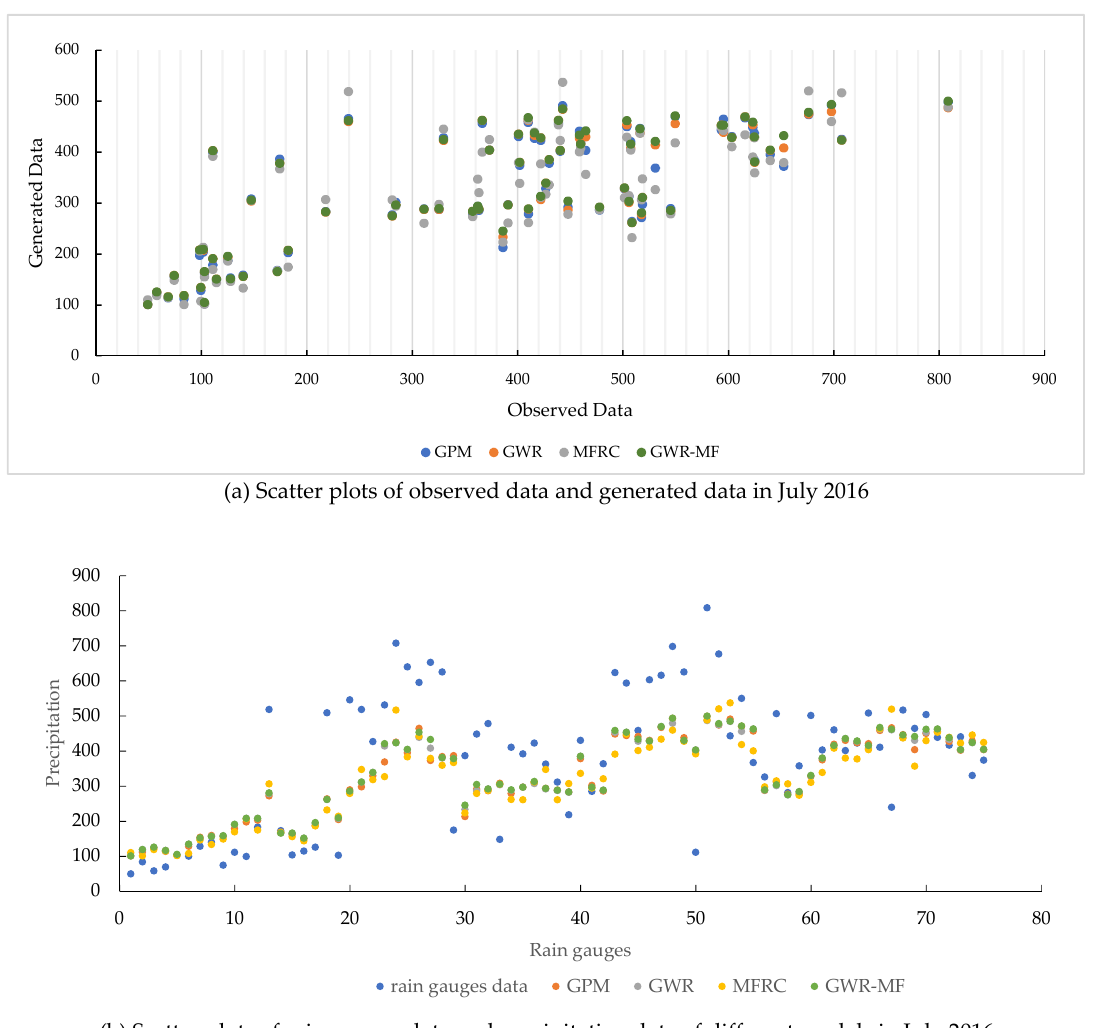
Figure 13. Scatter plots of rain gauges observation data and precipitation data of GPM product, GWR model, MFRC model, and GWR-MF model in July 2016. ( a ) Scatter plots of observed data and generated data in July 2016, ( b ) Scatter plots of rain gauges data and precipitation data of different models in July 2016. Table 2. CC and bias values of four precipitation grids in July 2016.